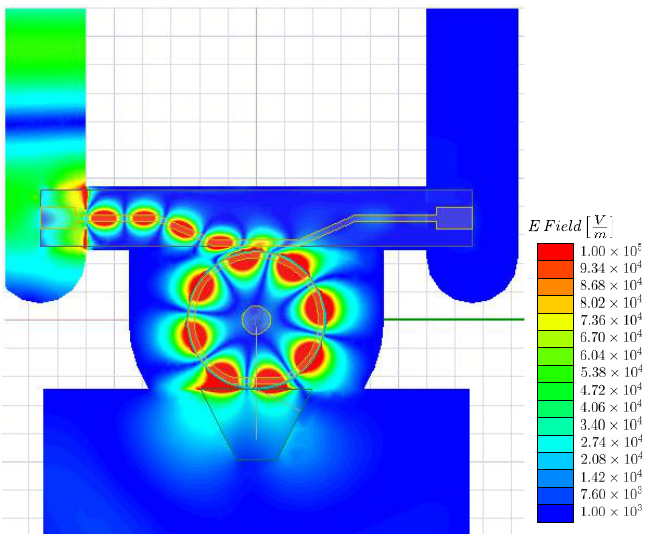
Figure 6. The electric field distribution along the main scheme components with an input power of 1